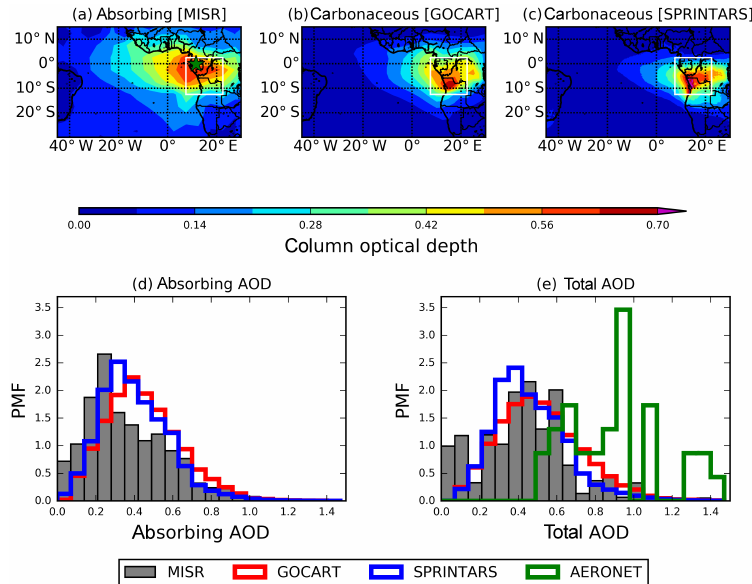
Figure 6. (a) Climatological mean optical depth of the spherical absorbing aerosols in MISR, dust AOD in (b) GOCART and (c) SPRINT- ARS over West Africa for July. Data from the eight Julys between 2000 and 2007 are averaged for MISR and GOCART. Spatiotemporal distributions of (d) the absorbing (or carbonaceous) AOD and (e) total AOD from MISR (gray bars), from GOCART (red lines), and from SPRINTARS (blue lines), covering the boxed emission source region (7.5–22.5 ◦ E, 12.5 ◦ S–2.5 ◦ N) are displayed. The green star in (a) dis- plays a location of the AERONET station in Lopé National Park. The green line in (e) represents the total AOD distribution in Lopé National Park for July